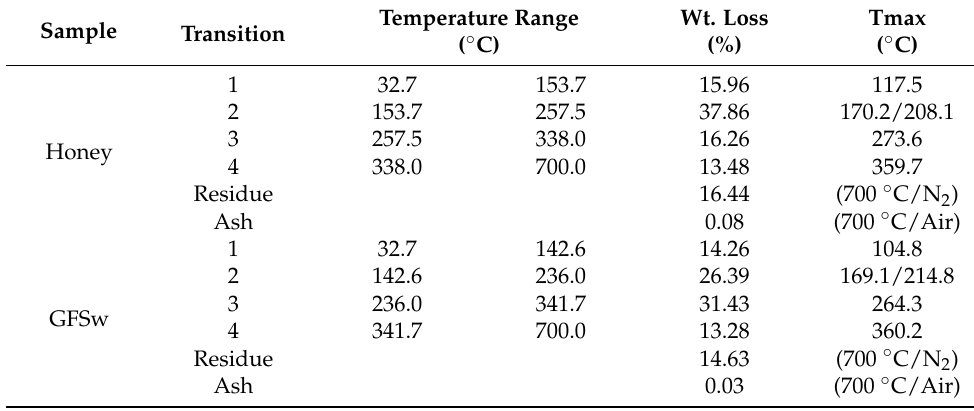
Table 4. TGA/DTG analysis of honey and GFS.